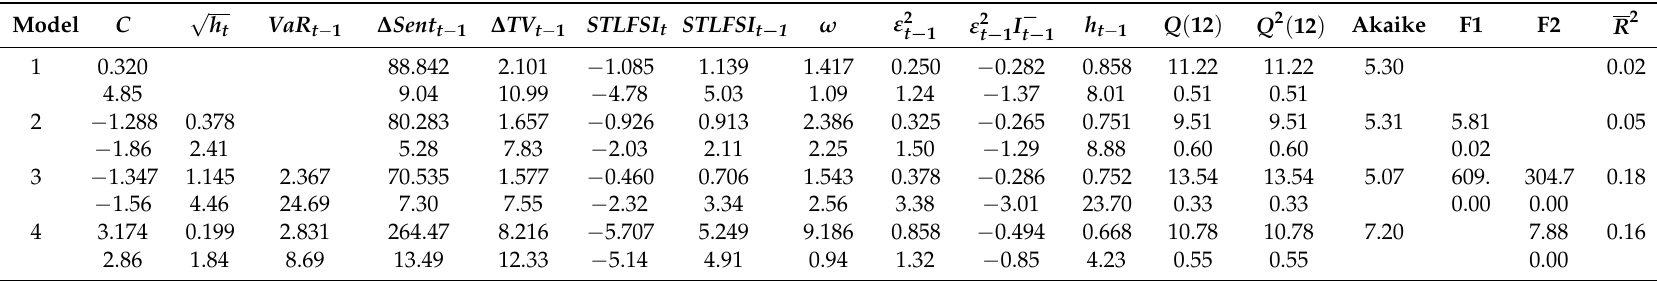
Table 3. Estimates of aggregate stock returns on conditional volatility, downside risk, investment sentiment, trading turnover, U.S. market stress based on a GED-TGARCH-M model.